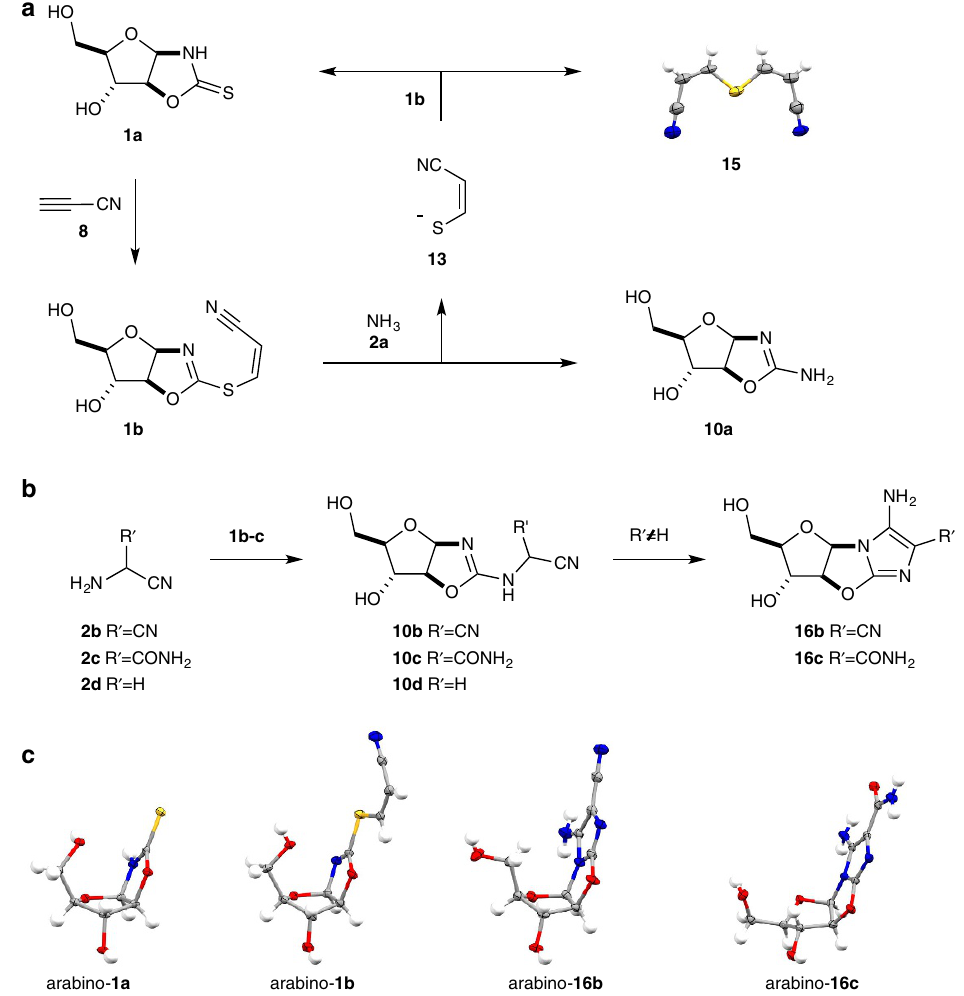
Figure 4 | Divergent aminooxazoline synthesis by sulfide displacement. ( a ) Ammonia ( 2a ) displacement of cyanovinylthiolate 13 from cyanovinyl arabinofuranosyl-oxazolidinone thione ( 1b ) to furnish pyrimidine precursor arabinofuranosyl-aminooxazoline ( 10a ) and concomitantly regenerate arabinofuranosyl-oxazolidinone thione ( 1a ). ( b ) Aminonitrile 2b–d displacement to furnish purine precursors arabinofuranosyl-aminooxazoline 10b–d , and selective cyclization of arabinofuranosyl-aminooxazoline 10b–c to aminoimidazoles 16b and 16c . ( c ) Single crystal X-ray structure of dicyanovinyl sulfide ( 15 ), arabinofuranosyl-oxazolidinone thione ( 1a ), cyanovinyl arabinofuranosyl-oxazolidinone thione ( 1b ), arabinofuranosyl-aminoimidazole ( 16b ) and arabinofuranosyl-aminoimidazole ( 16c